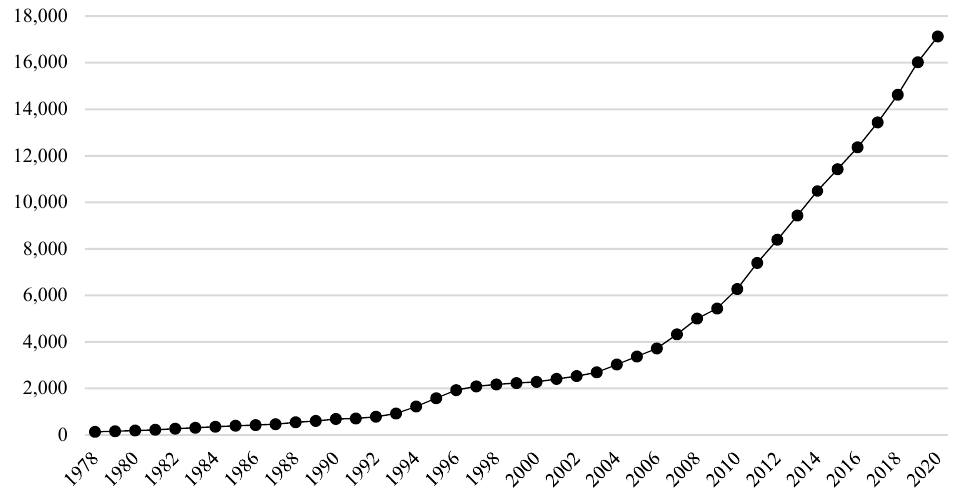
Figure 5. Income of rural residents (yuan) from 1978 to 2020. Notes: Data from China’s National Bureau of Statistics.